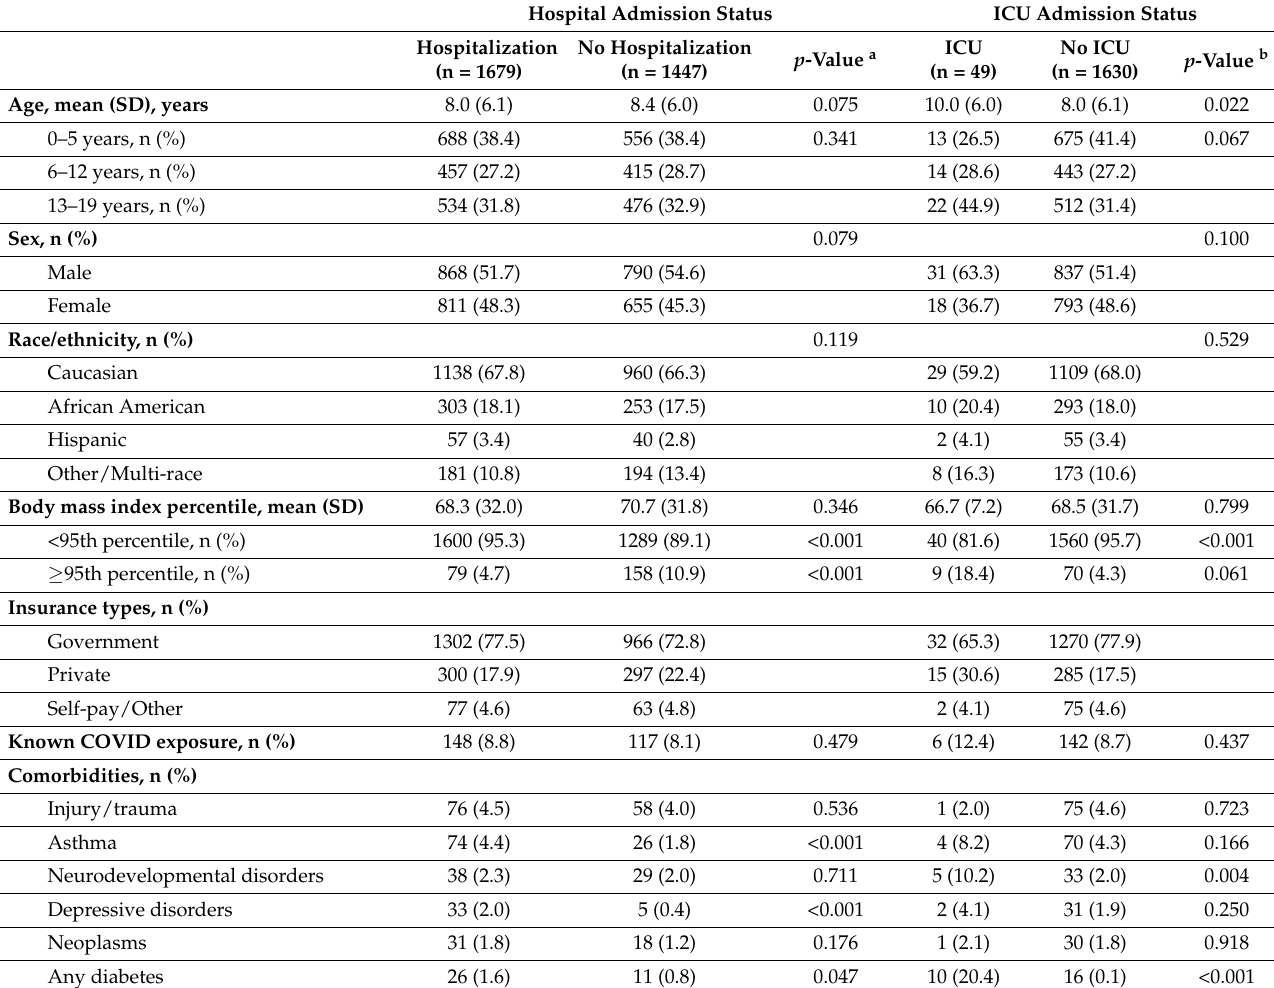
Table 1. Demographics and baseline characteristics of pediatric patients with COVID-19 positive results by hospitalization and intensive care unit (ICU) admission status, March 2020–March